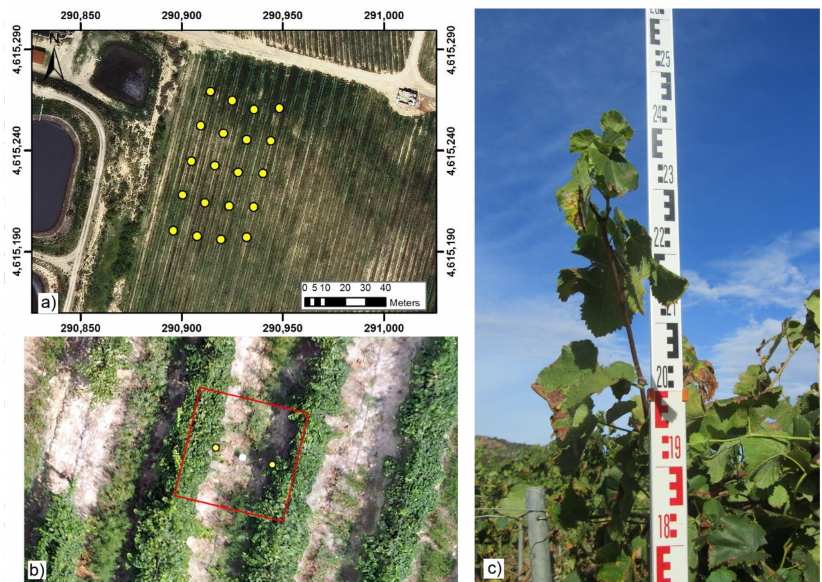
Figure 4. Experimental set for validating the results: ( a ) validation point grid in Field A on July; ( b ) a vector squares used for classification validation (yellow points indicate the positions of 40 true height data, and the white square is the artificial target placed in the field); ( c ) measurement of the vine height.